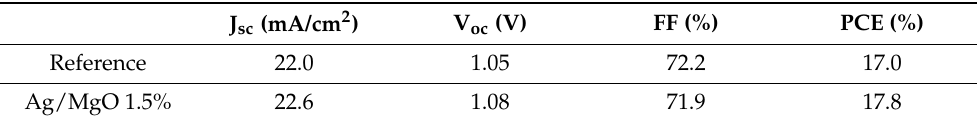
Table 2. Main performance parameters for the best reference cell and the best optimized device with Ag/MgO NPs. J sc (mA/cm 2 ) V oc (V) FF